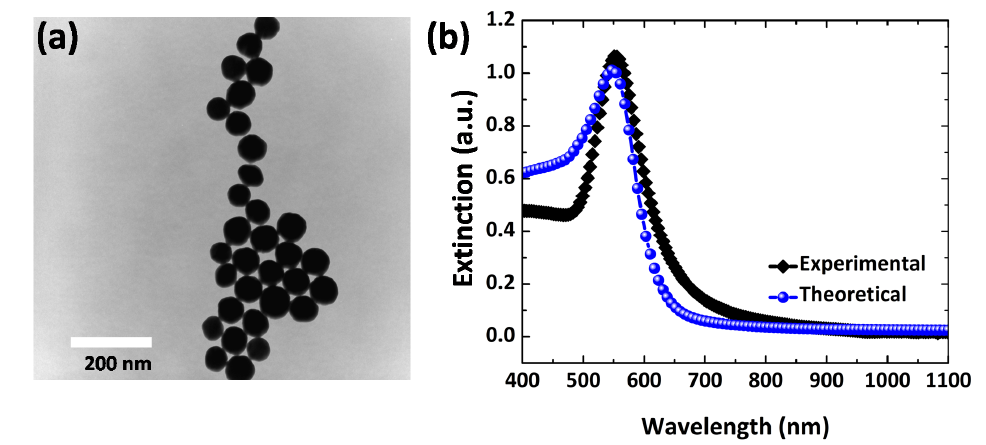
Figure 3. ( a ) TEM image of Au nanospheres and ( b ) extinction spectrum obtained both experimentally (black) and theoretically (blue). The average size of Au NPs for spectral and computational analysis is ∼ 50 nm.